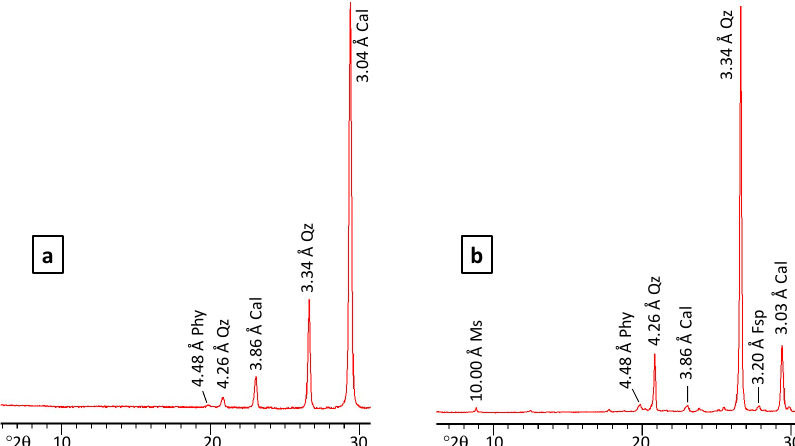
Figure 15. Representative XRD patterns of samples from the Tablate area in the southeastern edge of the Granada Basin. ( a ) Calcite-rich samples from calcarenite beds. ( b ) Quartz-rich grey sands. Cal: Calcite, Qz: Quartz, Fsp: Feldspars, Phy: Phyllosilicates, Ms: Muscovite. Mineral abbreviations according to Whitney and Evans [80]. Table 6. XRD analysis of the samples from Tablate A locality in the southeastern edge of the Granada Basin. The distance corresponds to the distance from fault, which is also plotted on the x-axes of the plots in Figure 13.